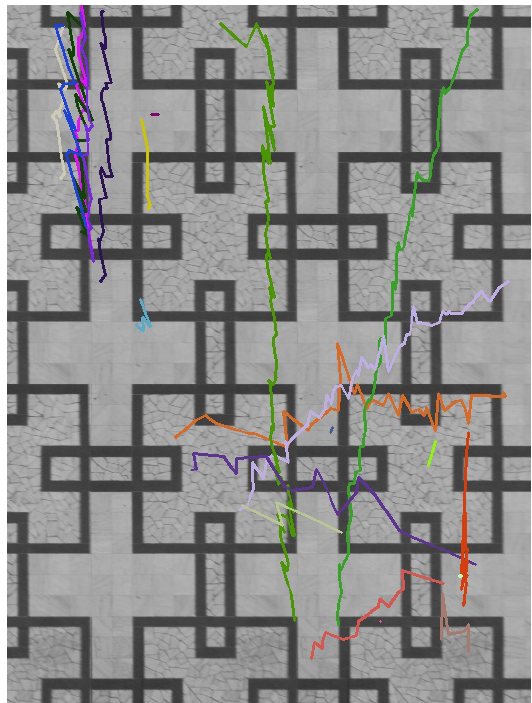
Figure 4: Trajectories mapped onto the rectified ground plane of the entrance hall of a